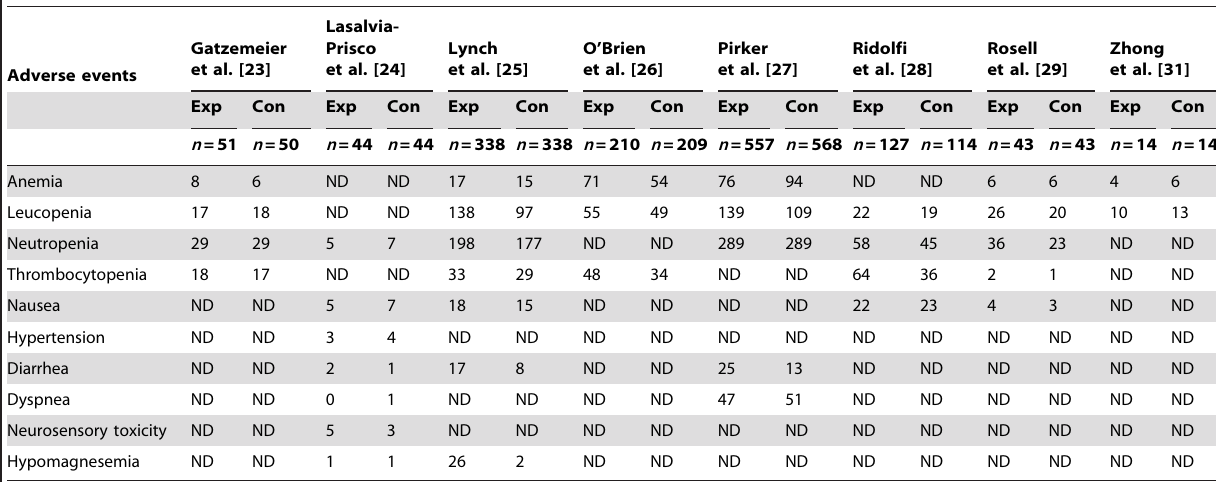
Table 4. Adverse events (grades $ 3) in advanced NSCLC patients*.